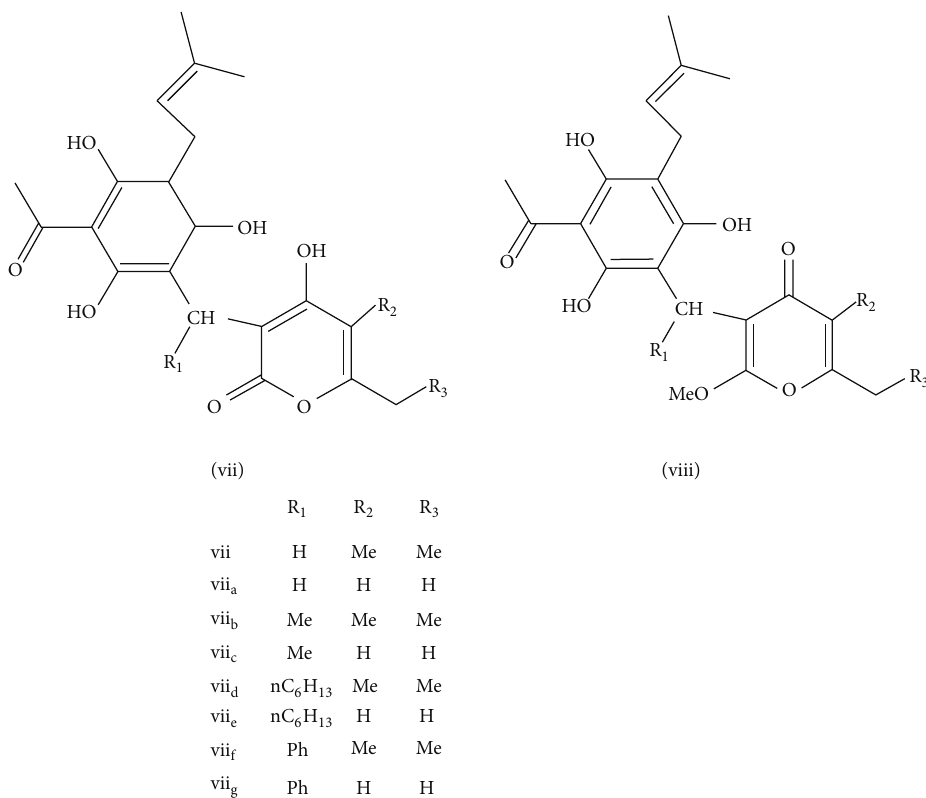
Figure 4: Structure-activity relationship of arzanol and its derivatives. (Adapted from Minassi et al. [21].)